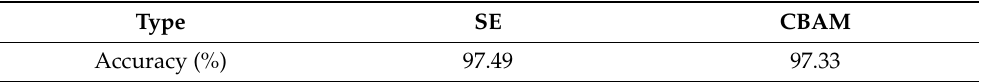
Figure 5. The CBAM block (FC represents the fully connected layers). Note the omission of some activation functions. Table 3. Comparison between the SE block and the CBAM block on the CULane validation set.